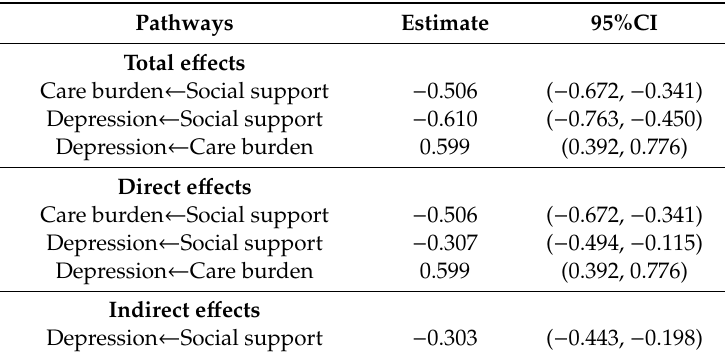
Table 5. The path coefficients between structural variables.